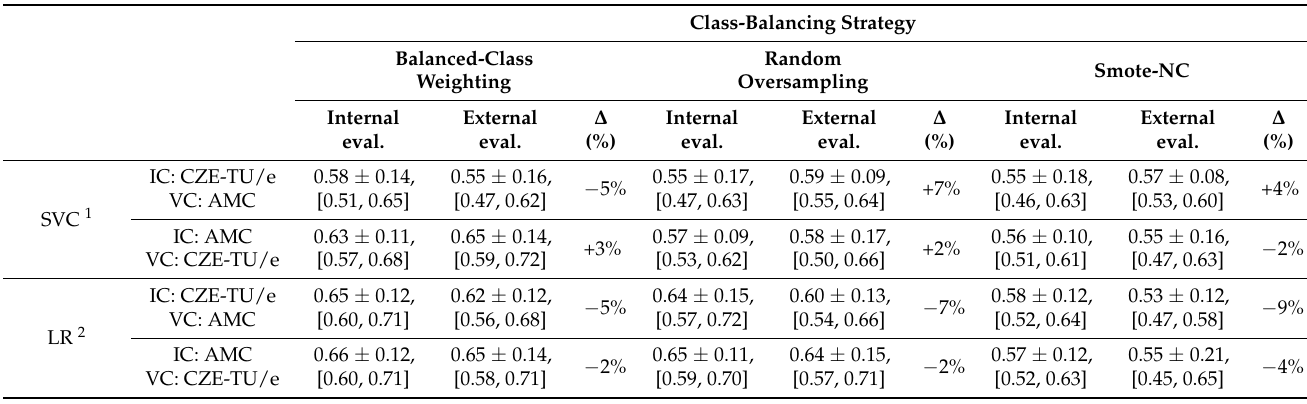
Table A1. Final evaluation, internal and external validation results comparisons based on AUC of the ROC curve. AUC is shown as mean ± standard deviation, within brackets are the confidence intervals at